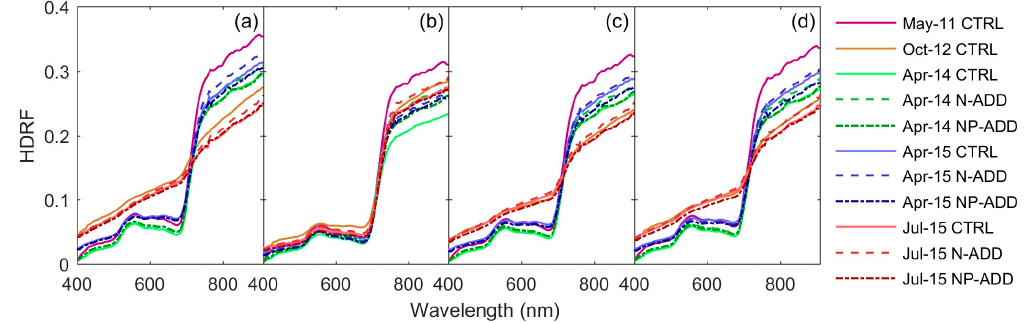
Figure 2. Mean spectra of different covers within a 1 km 2 square centered on the Eddy Covariance (EC) towers: ( a ) Grass; ( b ) Trees; ( c ) Vegetation (grass + trees); and ( d ) All covers.